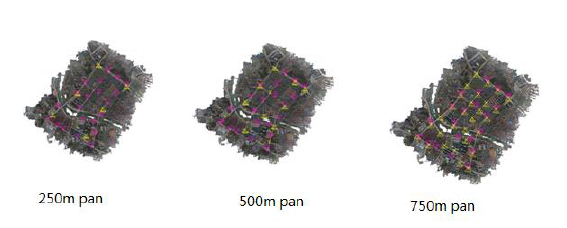
Figure 1. Control Points and Check Points Distribution